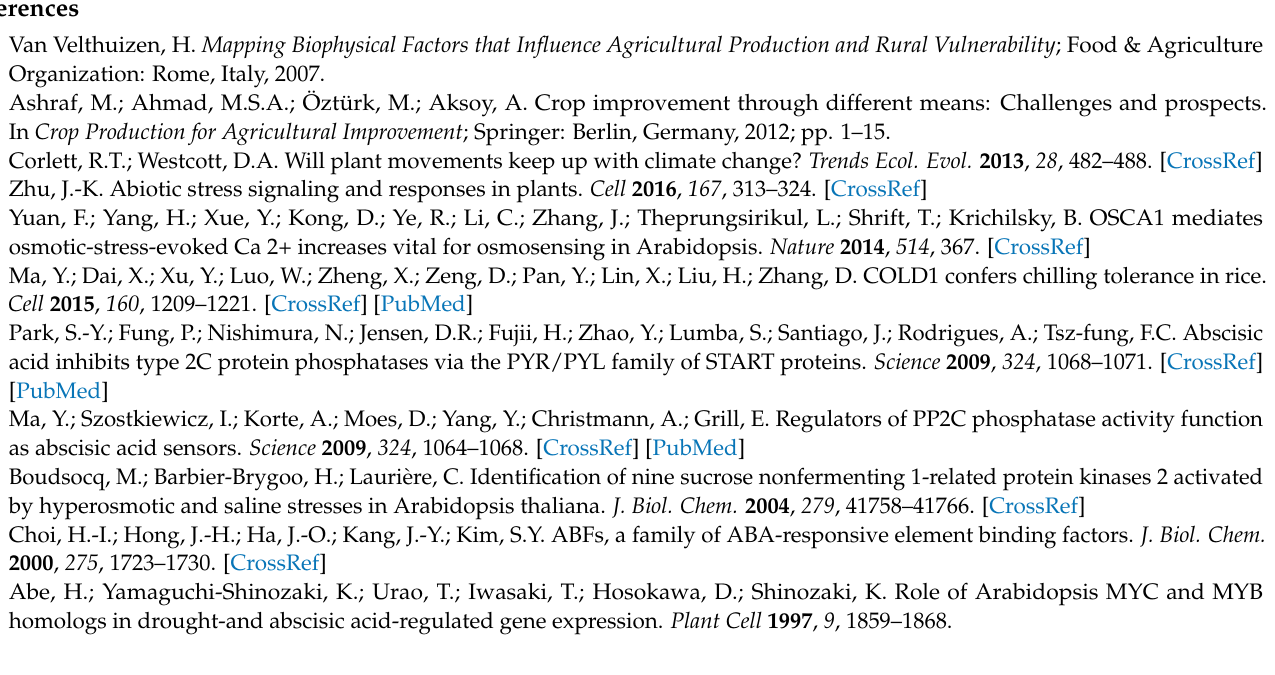
Figure S1: Leaf disc assay of OsCBE1 lines under salt and cold stress, Figure S2: Co-expression and Co-ocurrence data between OsCBE1 and putative substrates, Figure S3: Negative control for OsCBE1 binding